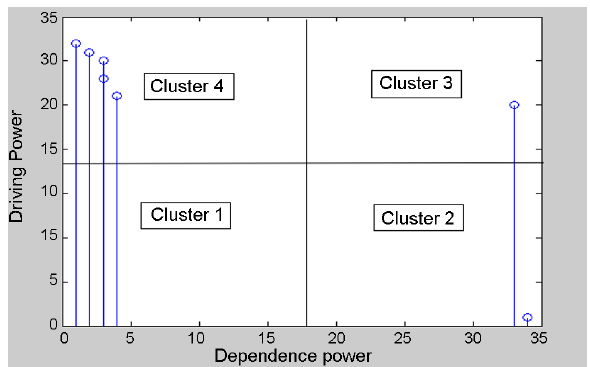
Figure 3. Driving and dependence power